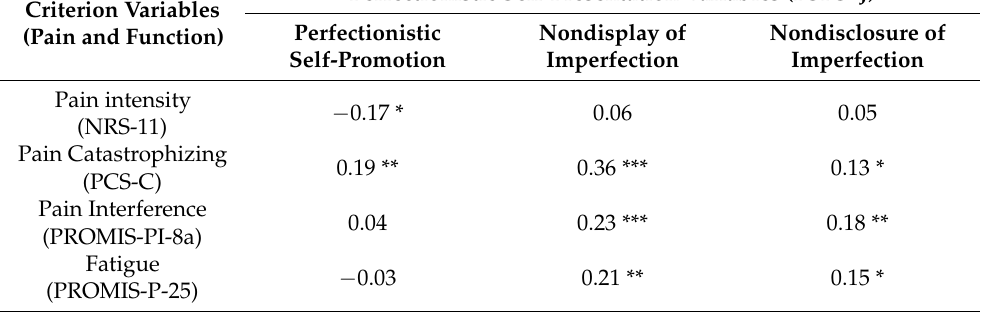
Table 3. Pearson correlations between measures of perfectionistic self-presentation and the study criterion variables.